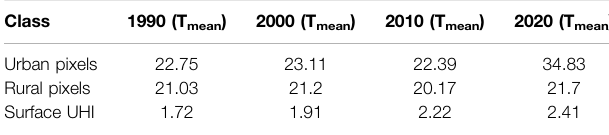
TABLE 4 | Surface urban heat island intensity of